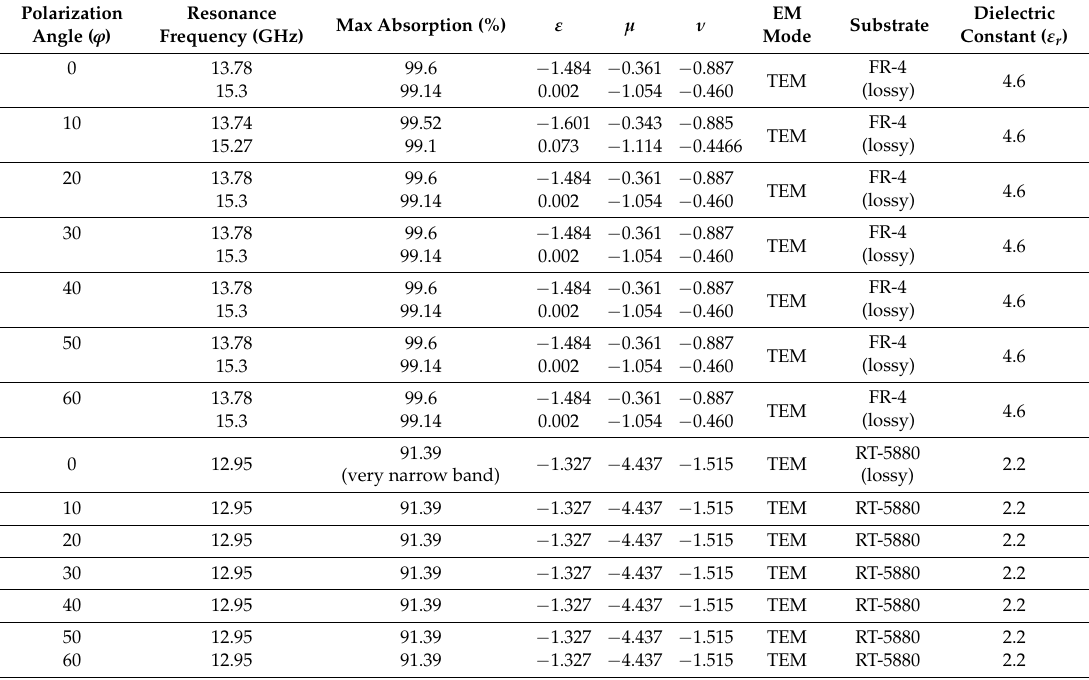
Table 3. Parametric characteristics study of proposed MM absorber at the resonance